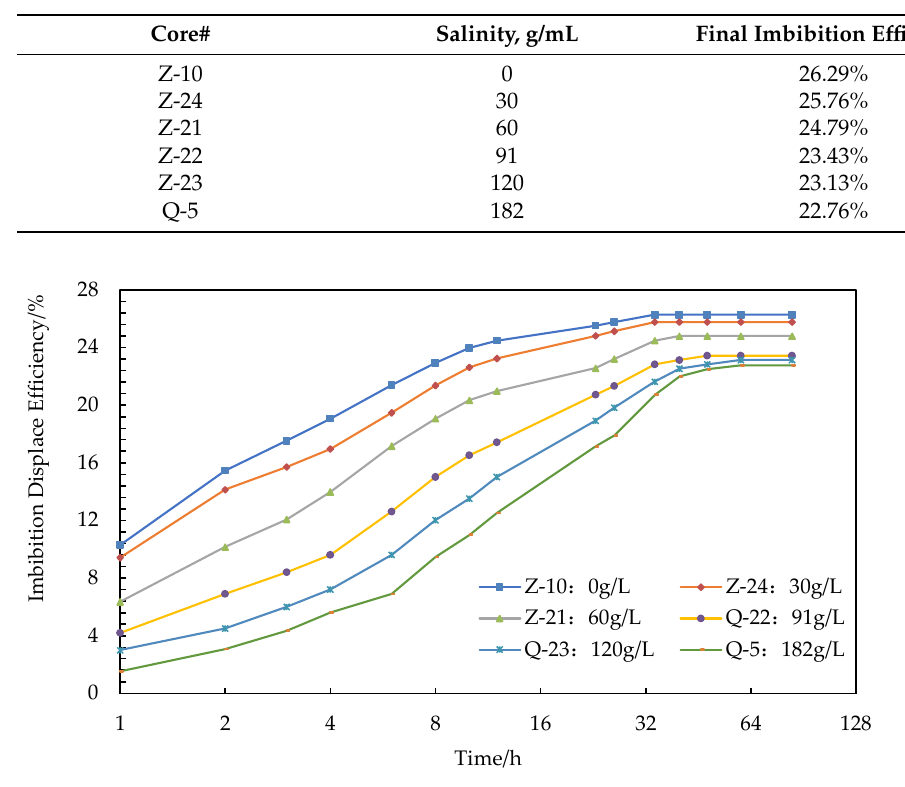
Figure 5. Displacement efficiency curve of imbibition for investigating salinity.